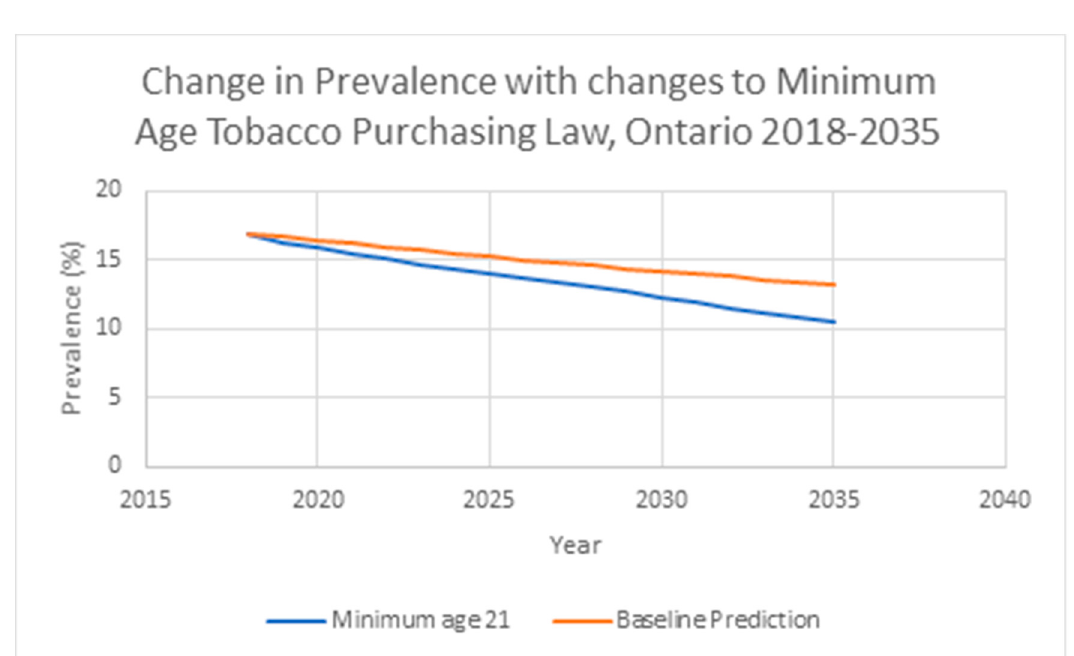
Figure 2. Model Predicted Smoking Prevalence, for Both Sexes, With and Without Increased Minimum Age Tobacco Purchasing Law, Ontario, 2018–2035.